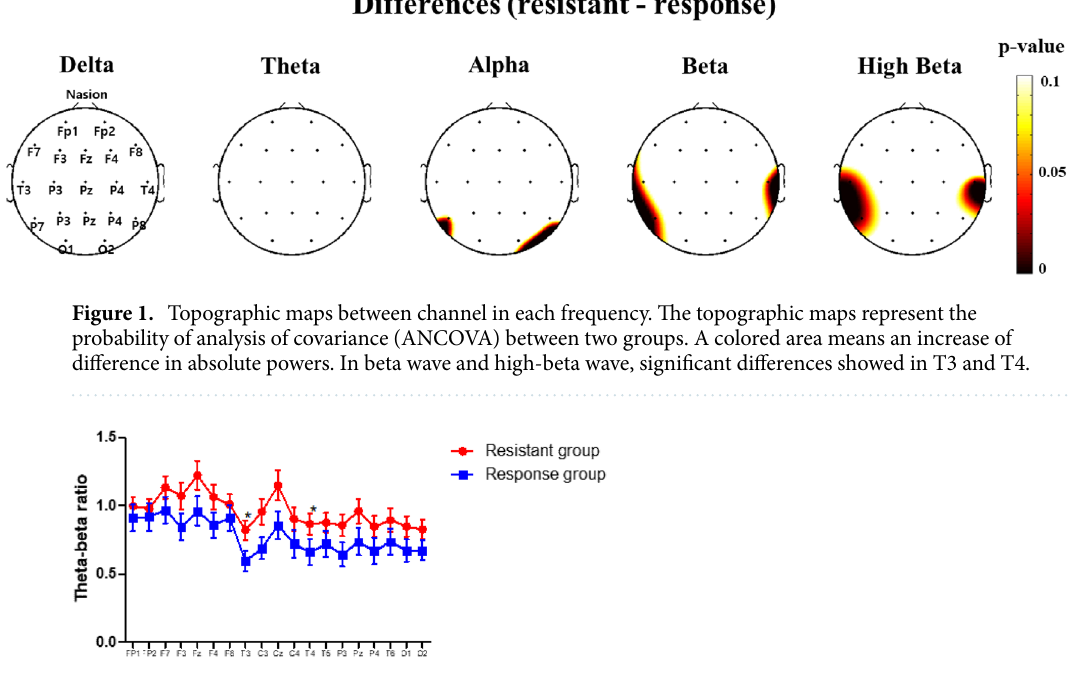
Figure 2. Theta-beta ratio between channel in each group. Figure 2 shows the difference in Theta-Beta ratio (TBR) between two groups for each channel. Each graph moves in a similar pattern for each channel. The width of the interval indicates standard errors. Even controlling for variation in age, sex, STAI score, and BDI score, significant differences showed in T3 and T4. * p < 0.05. STAI-S: State-Trait Anxiety Inventory, BDI: Beck Depression Inventory, ANCOVA: analysis of